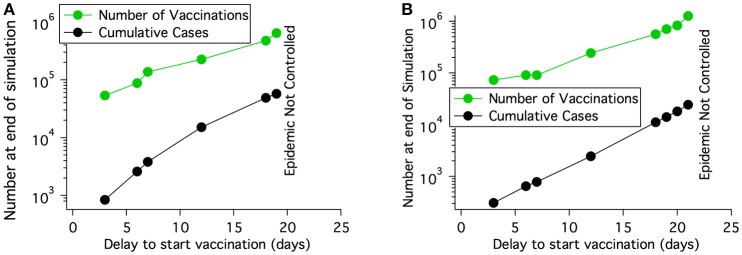
For a fairly uniform population density of 68 cattle/km2 and a rinderpest virus having the parameters of lineage-1, the number of vaccinations needed to control an epidemic increases rapidly with the delay in starting vaccination after rinderpest is identified. If the delay is long enough, the epidemic can not be extinguished. (A) No long distance spread and no transmission reduction. (B) Long distance spread is allowed to the locations shown in Figure 8B until 1 day after disease detection. Transmission is reduced by a factor of 2 also 1 day after disease detection.